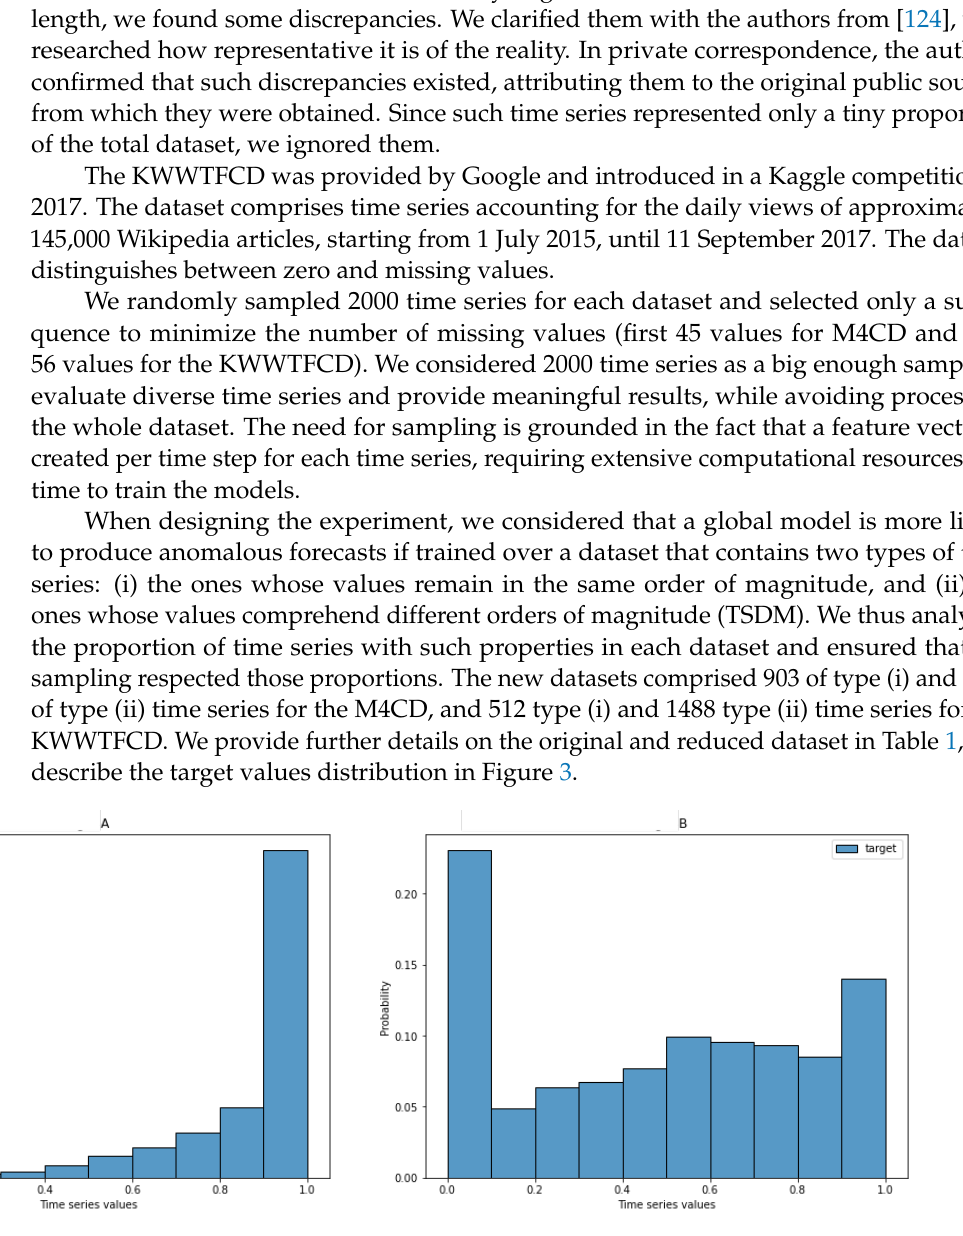
Figure 3. Target values distribution. ( A ) describes values for M4CD, while ( B ) describes values for